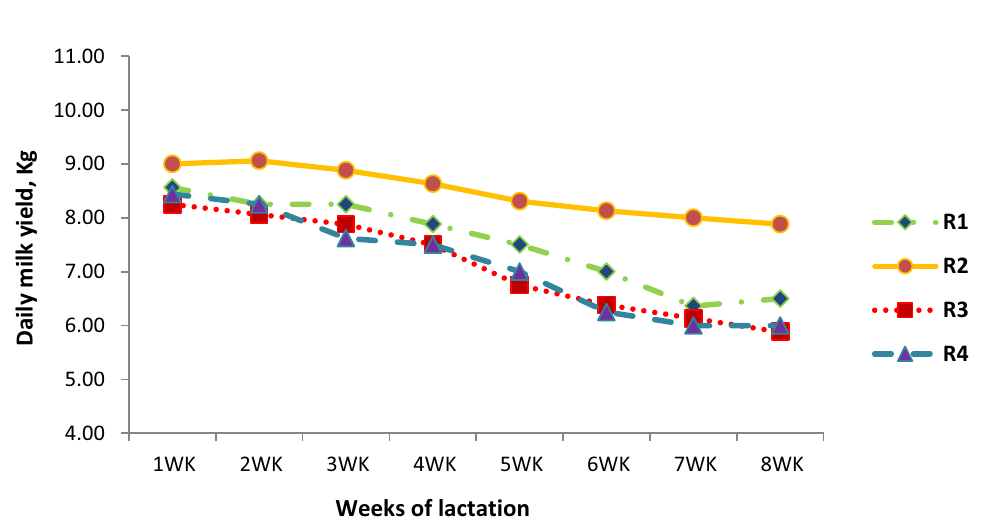
Fig. 1 Lactation curve of different buffalo groups fed experimental diets